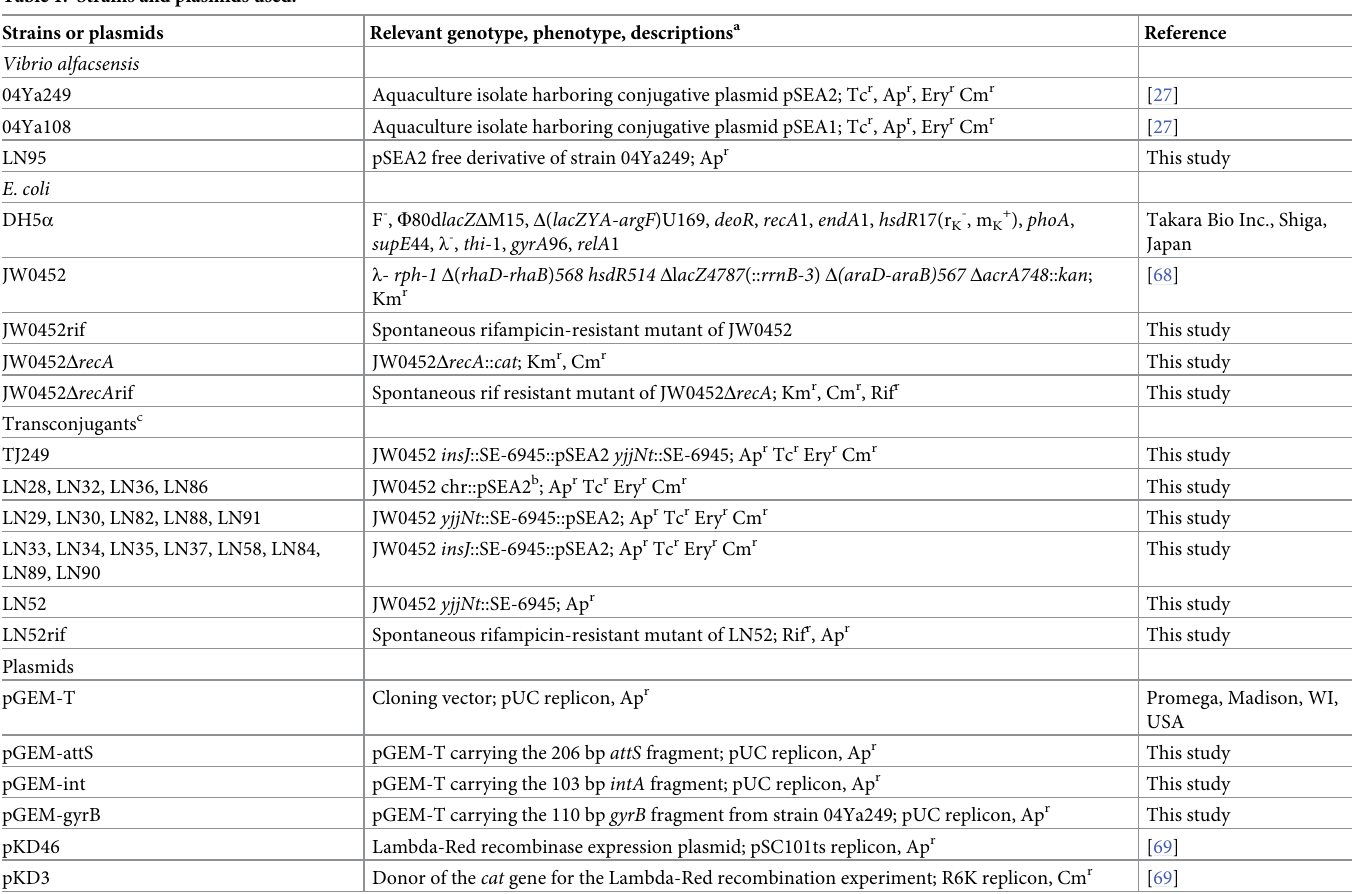
Table 1. Strains and plasmids